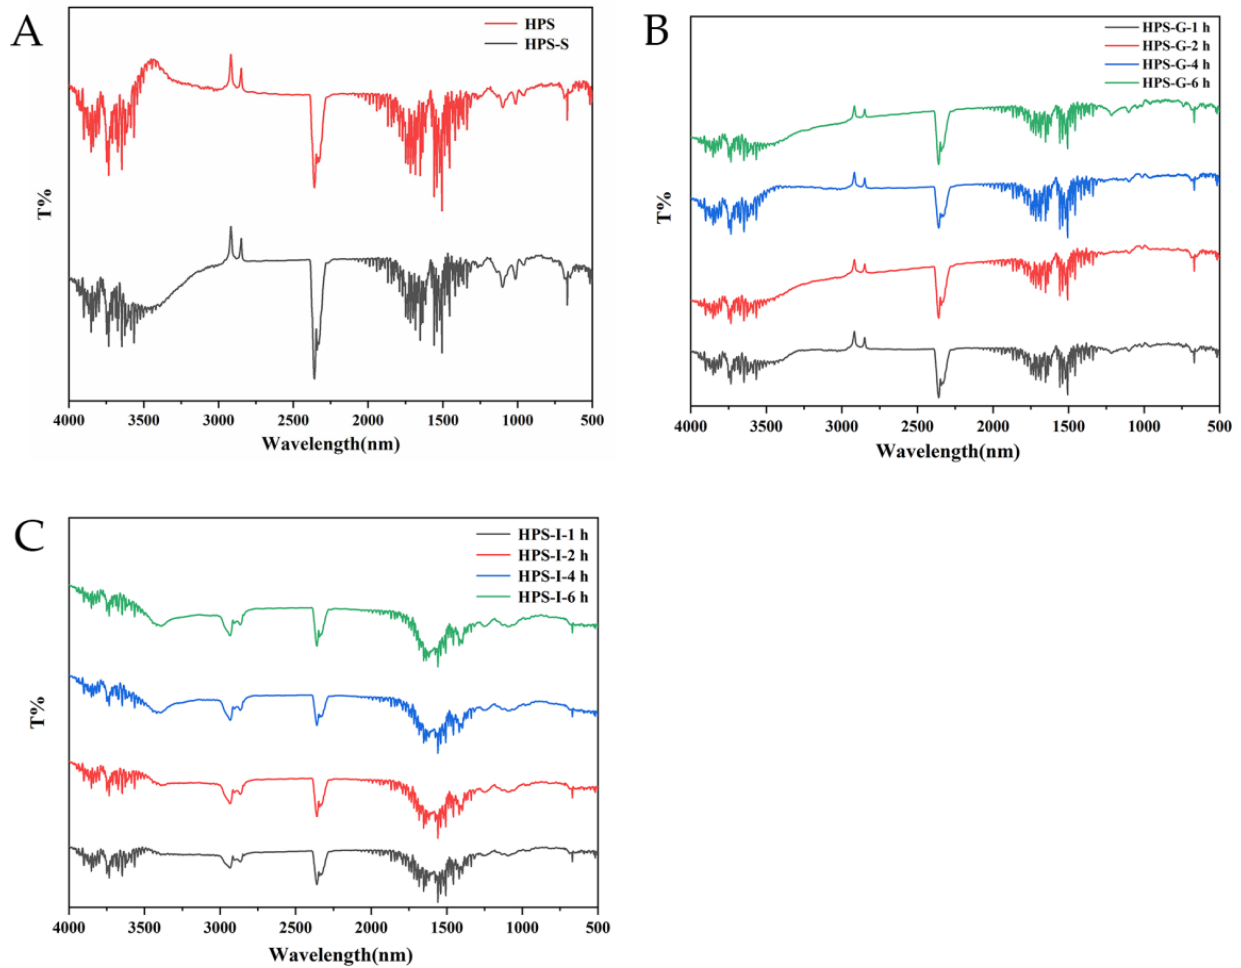
Figure 2. Changes in FT-IR spectra during digestion. HPS, hawthorn polysaccharides; HPS-S, sali- vary digestion of HPS for 0.05 h ( A ); HPS-G-1 h, HPS-G-2 h, HPS-G-4 h, and HPS-G-6 h ( B ), sali- va–gastric digestion of HPS for 1, 2, 4, and 6 h, respectively; HPS-I-1 h, HPS-I-2 h, HPS-I-4 h and HPS-I-6 h ( C ), saliva–gastrointestinal digestion of HPS for 1, 2, 4, and 6 h, respectively.